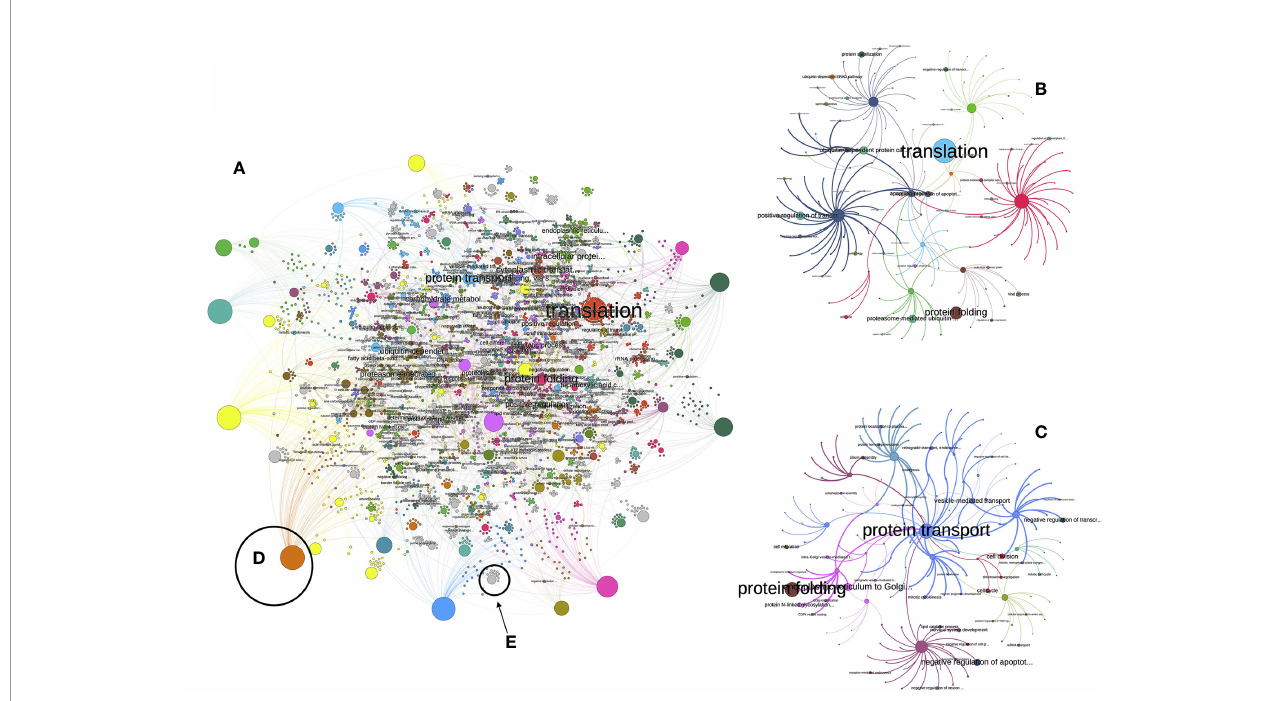
FIGURE 2 | (A) The view of the network of low-level processes of the unfed R. sanguineus ticks. The fi gure is not intended to follow every single link but is just a visual depiction of the enormous complexity of that network. Each circle is either a protein or a process. Only the processes with a PageRank higher than 1 are labelled. Colors mean for clusters, or groups of proteins and processes that tend to appear together more frequently than with others. The size of each circle is proportional to its PageRank (some large unlabelled circles are proteins). In both (B, C) , we plotted the subnetworks related to the “ translation ” and “ protein folding ” processes, aiming to improve the visualization of how the network is build, with the same conventions of colors and sizes. More examples are illustrated in (D) (in which a very prominent protein is linked with many processes, because many links start in it) or in (E) (in which a low-importance process of medium size is linked to a few proteins involved in the process, with low importance and smaller